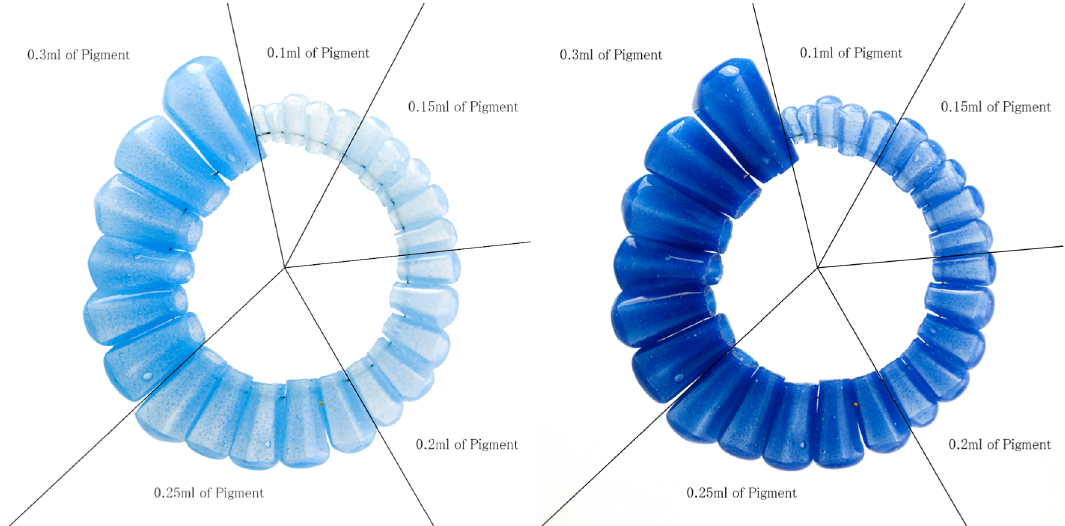
Figure 1 | Example of a Single Pigment Test: Blue 27˚C in its unchanged and changed state.